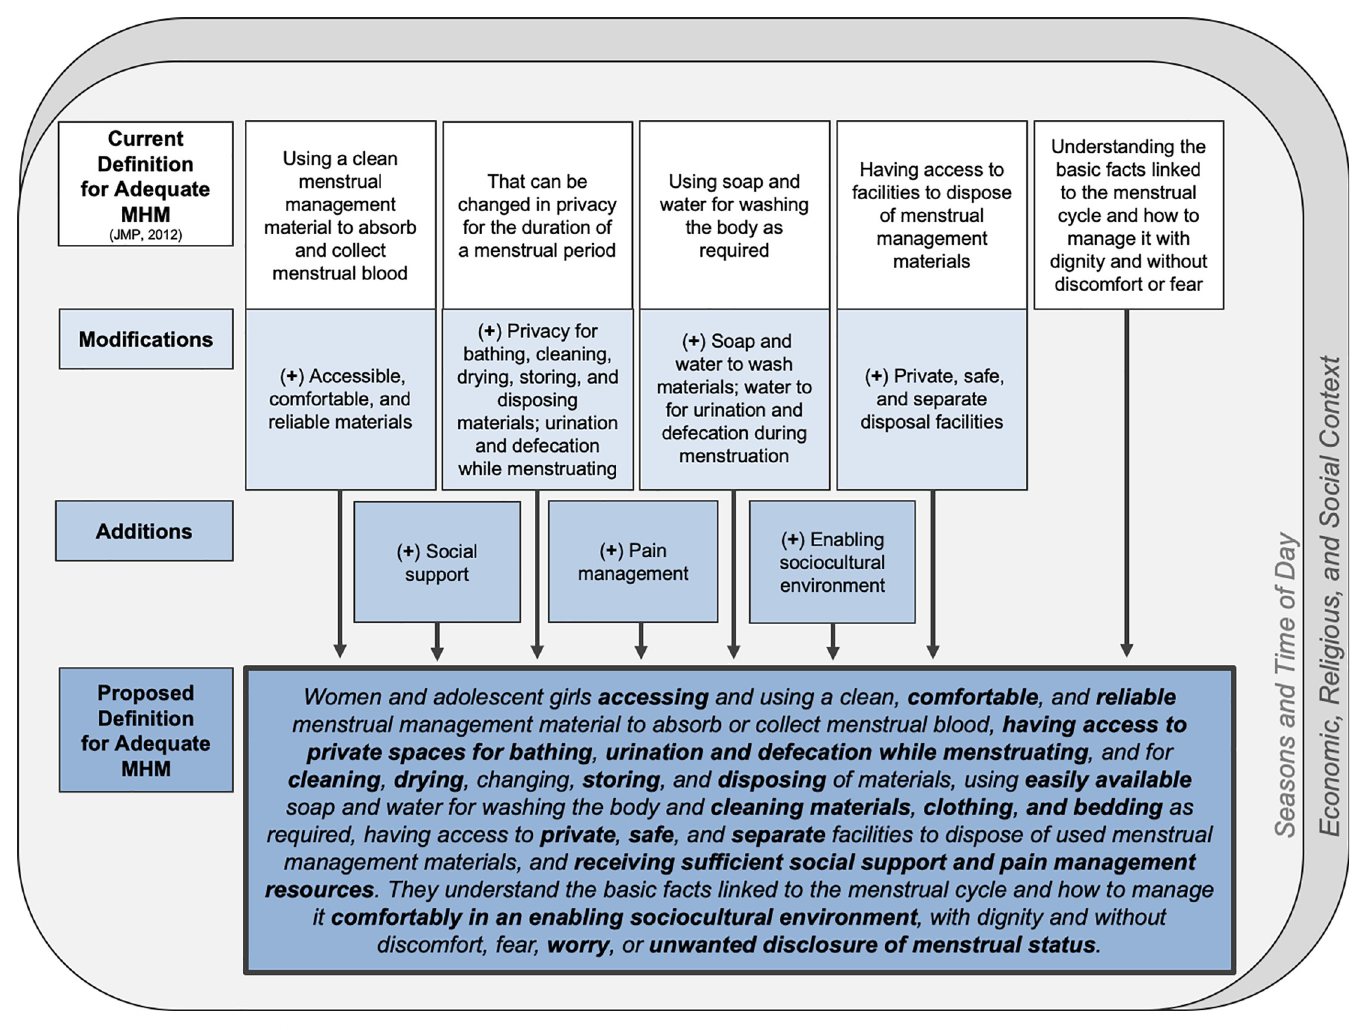
PLOS ONE | https://doi.org/10.1371/journal.pone.0220114 August 1,